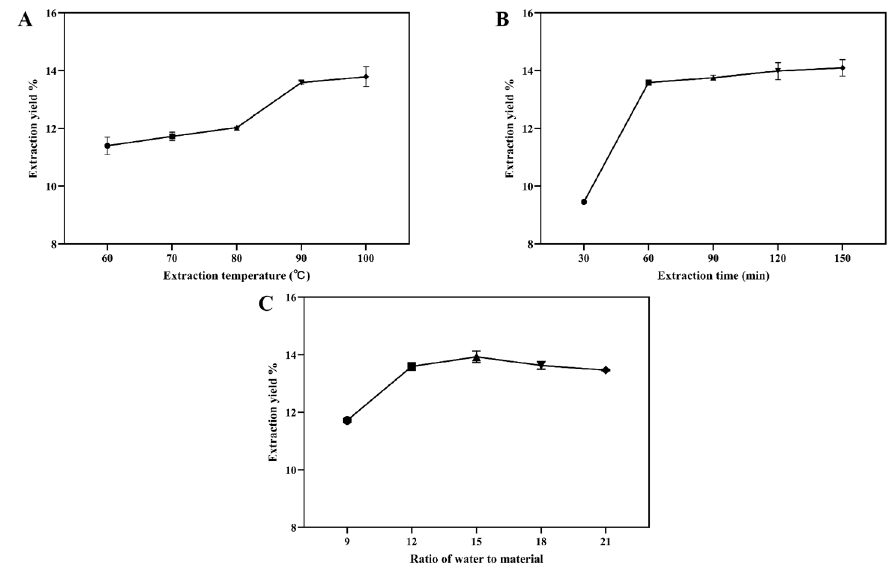
Figure 1. Effects of the extraction temperature ( A ), time ( B ), and water-to-raw material ratio ( C ) on the extraction yield of LBPs.